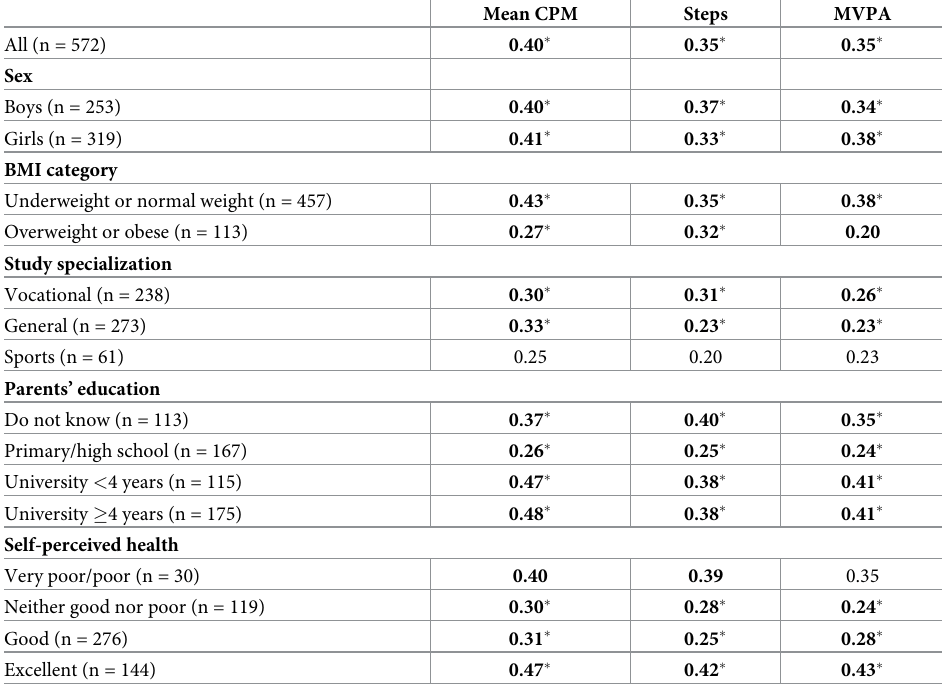
Table 4. Spearman rank correlations between SGPALS ranks and accelerometer-measured physical activity. The Fit Futures Study 2010–2011. Mean CPM Steps MVPA All (n = 572) 0.40